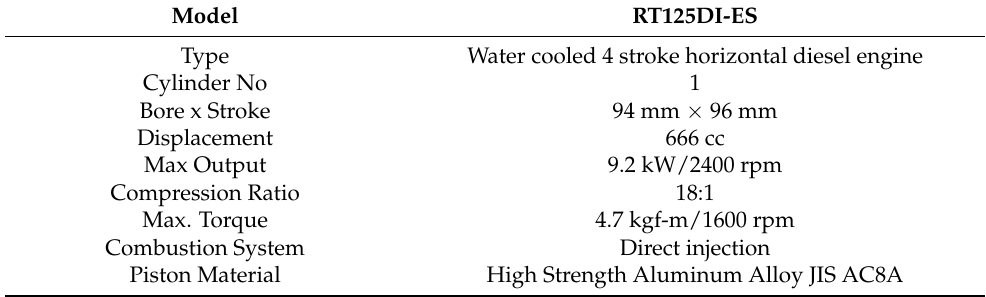
Figure 1. Schematic diagram for the experimental setup.